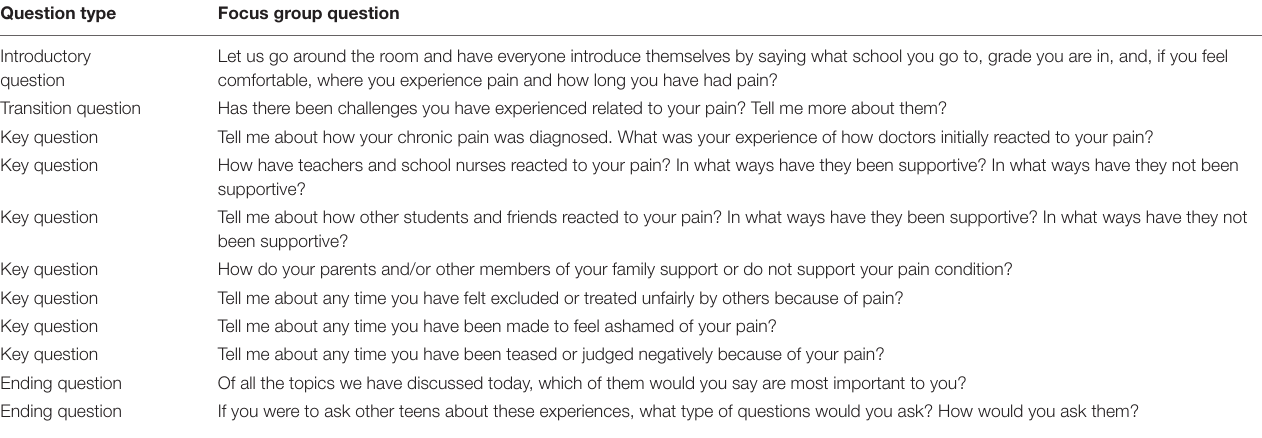
TABLE 2 | Focus group question